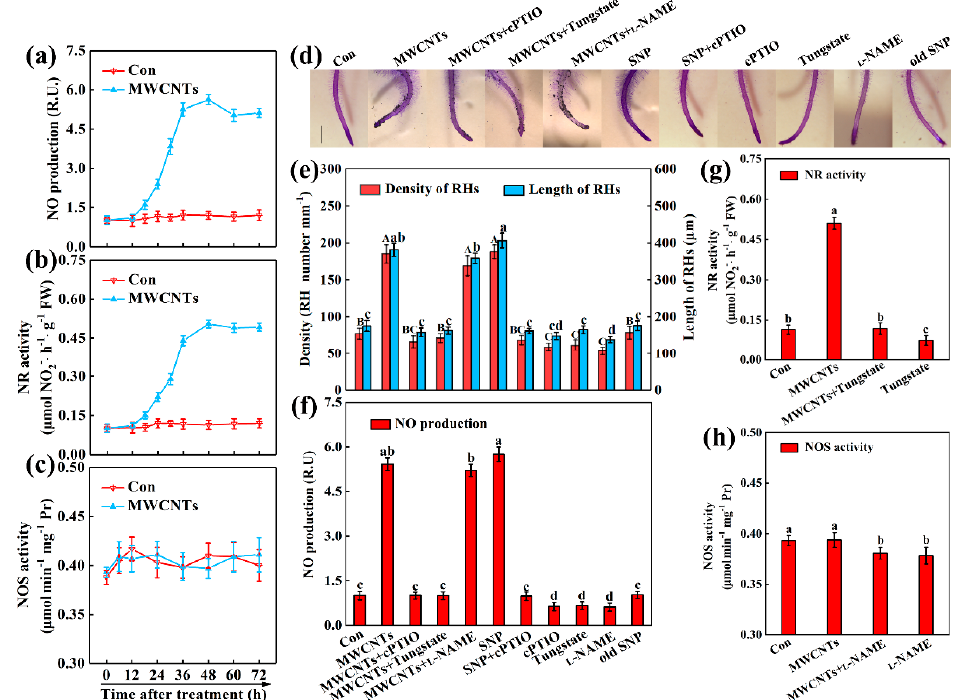
Figure 3. Nitric oxide production and root hair growth induced by MWCNTs were sensitive to cPTIO and tungstate. Two-day-old rapeseed seedlings were treated with 100 mg/L MWCNTs, 20 μ M SNP, 100 μ M cPTIO, 100 μ M tungstate, and 100 μ M L -NAME, alone or their combinations. The sample without chemicals was the control (Con), and 20 μ M old SNP was used as the negative control of SNP. Afterward, the time-course changes in NO production ( a ), NR ( b ), and NOS activities ( c ) were detected (in control and MWCNTs treated samples). After treatments for 3 days, corresponding photographs ( d ), the root hair (RH) density and length ( e ), NO production ( f ), NR ( g ), and NOS activities ( h ) were provided or determined. Scale bar = 1 mm. Within each set of experiments, bars with different letters are significantly different at p < 0.05, according to Duncan’s multiple range test.